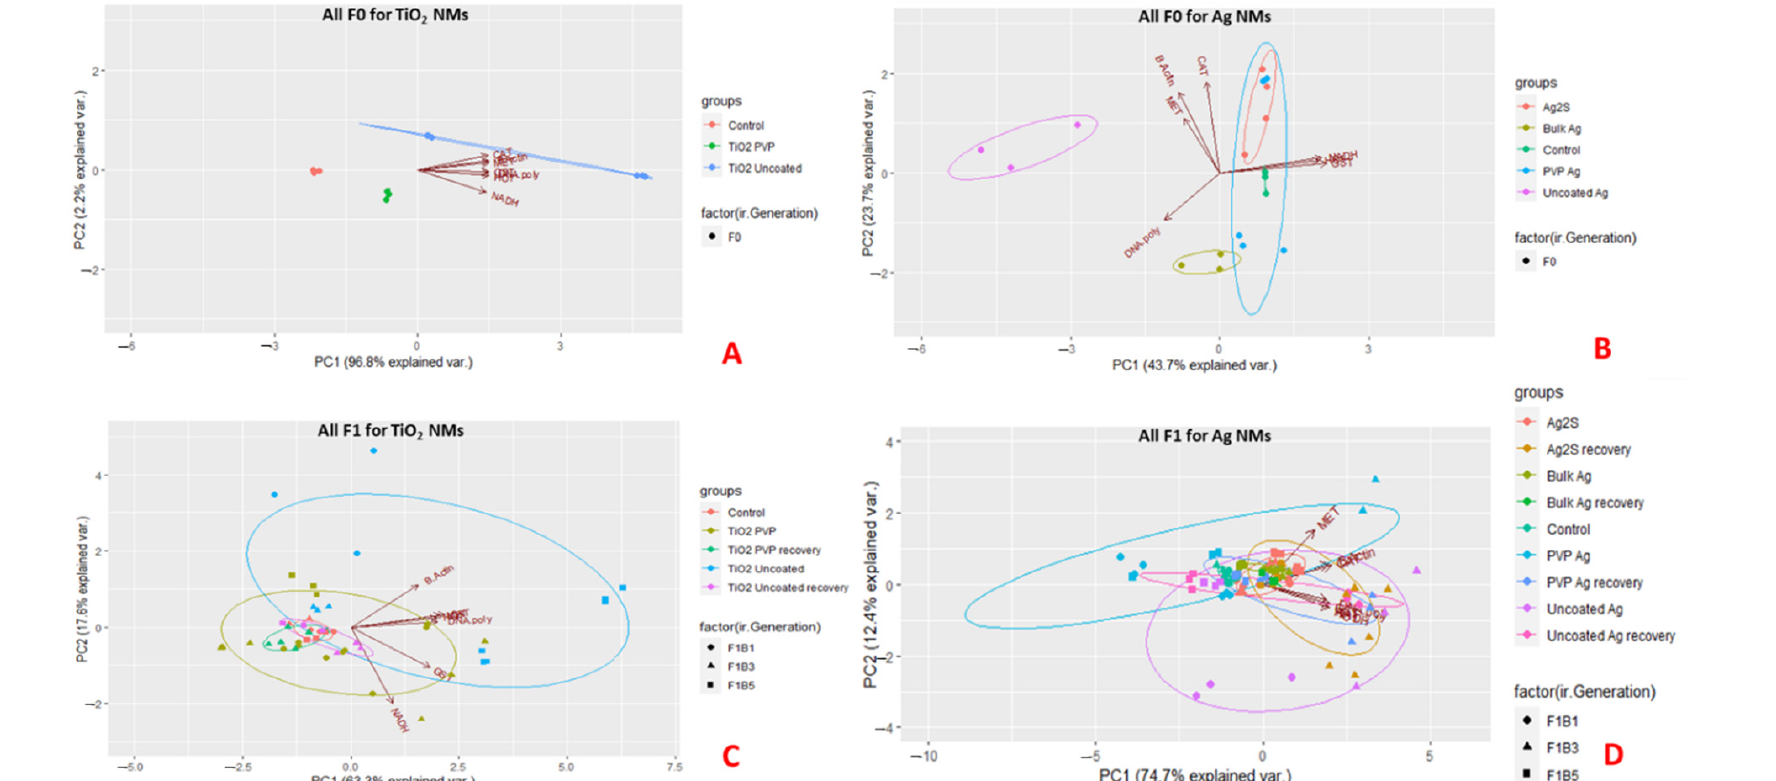
Figure 4. 2D Principal Components Analysis (PCA) variable biplots showing the variation of the exposed and recovery broods responses to the NMs, plotted using their projections onto the first two principal components, combined with the gene expression plotted using their weights for the components. The red arrows indicate the direction of maximum loading of each gene to the overall distribution. The circles (Ag NM treatments only) show the F0 parents, the triangles show the first F1 brood (F1B1), squares show the third F1 brood (F1B3) and the crosses show the fifth F1 broods (F1B5). The colours represent each of the NMs. The PCAs are split into: ( A ) F0 generations exposed to the TiO 2 NMs; ( B ) All exposed and recovery broods of the F1 generations for the TiO 2 NMs; ( C ) F0 generations exposed to the Ag NMs; and ( D ) All exposed and recovery broods of the F1 generations for the Ag NMs. PCAs for each of the F1 germline generations (F2-4) are provided in the supporting information. Key = Glutathione S-transferase (GST), dehydrogenase (NADH), β -Actin (B-Actin), catalase (CAT), metallothionein (MET), DNA Polymerase (DNA-poly) and heme-oxygenase-1 (HO1). All genes are normalised to 18S ribosomal RNA (18S).